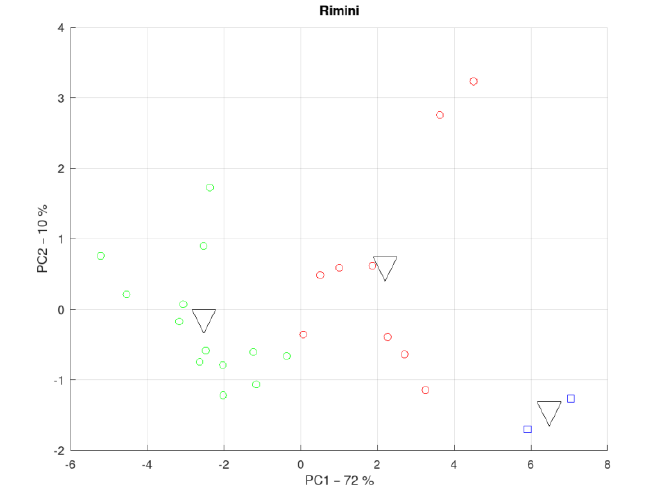
Figure 6. District of Rimini 2D-Score plot showing PC1 vs. PC2 and clusters: first cluster in red, second cluster in blue, and third cluster in green.